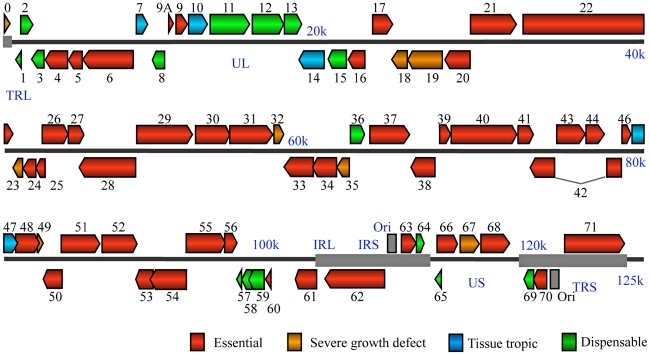
VZV genome-wide functional profiling based on analysis of viral mutants with single open reading frame deletion mutants.Genomic organization and ORFs arrangement are based on the viral sequence of the VZV pOka strain. Each VZV ORF is color-coded according to the growth properties of its corresponding virus gene-deletion mutant in cultured MeWo cells and human fetal skin organ cultures. The grey lines for ORF42 represent a splicing junction. For all growth curves, wild-type infections served as positive controls and mock infections served as negative controls.